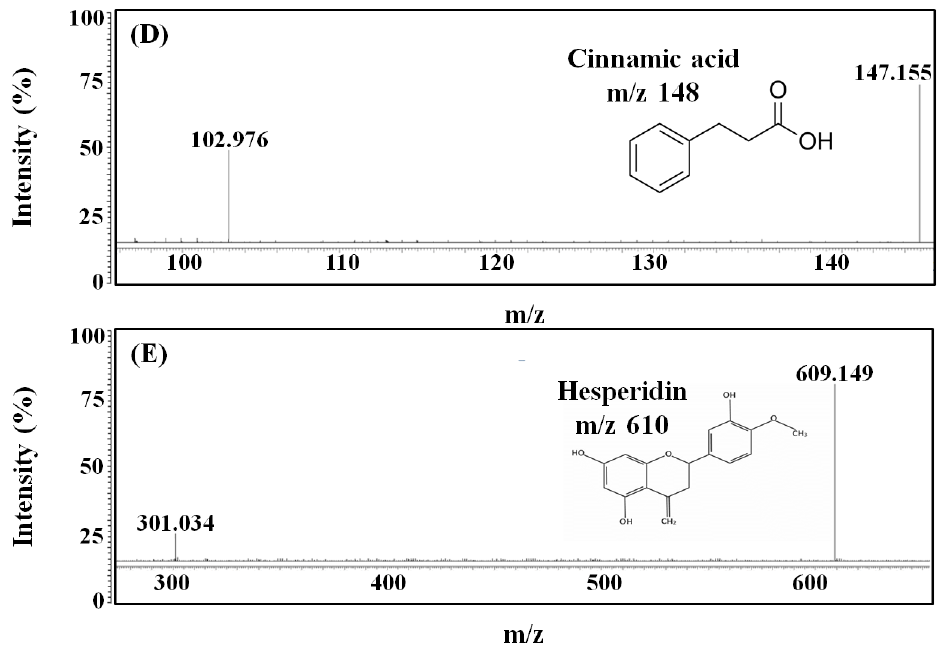
Figure 5. LC-MS/MS spectra for the analysis of main components in BCS. ( A ) quercetin, ( B ) gallic acid, ( C ) coumarin, ( D ) cinnamic acid, and ( E ) hesperidin. BCS: bioconverted chestnut inner shell extracts.